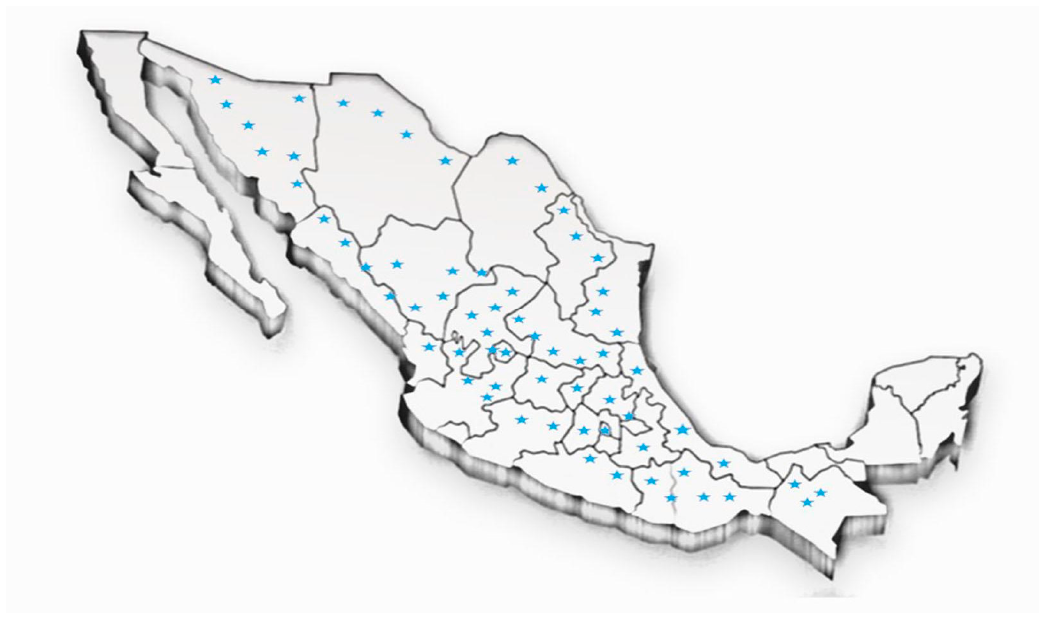
Figure 2. Geographical distribution of Eysenhardtia [22,23].